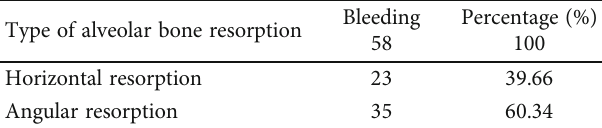
Table 4: Type of alveolar bone resorption at bleeding